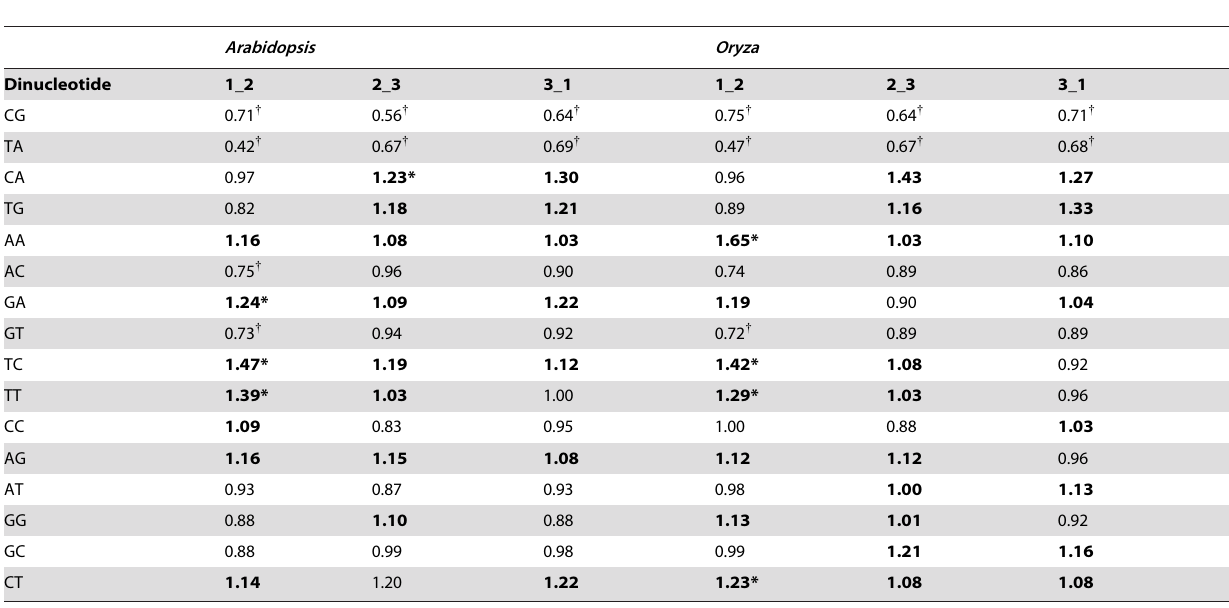
Table 3. Dinucleotide biases observed in the coding sequences of Arabisopsis and Oryza .